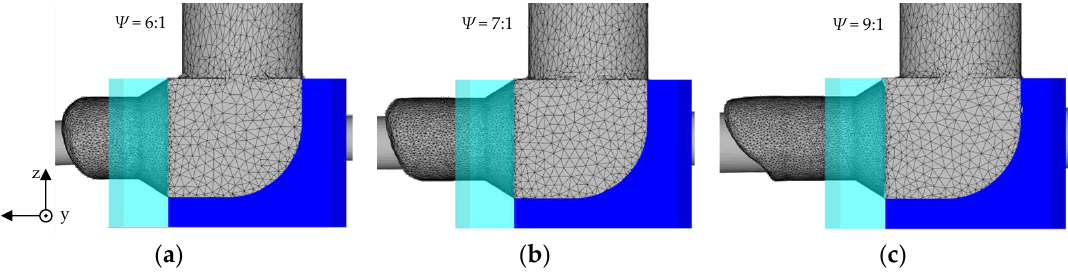
Figure 13. Material flow inside the tool and through the die after a stroke of the dummy block of 74 mm. ( a ) For an extrusion ratio of 6:1; ( b ) For an extrusion ratio of 7:1; ( c ) For an extrusion ratio of 9:1.